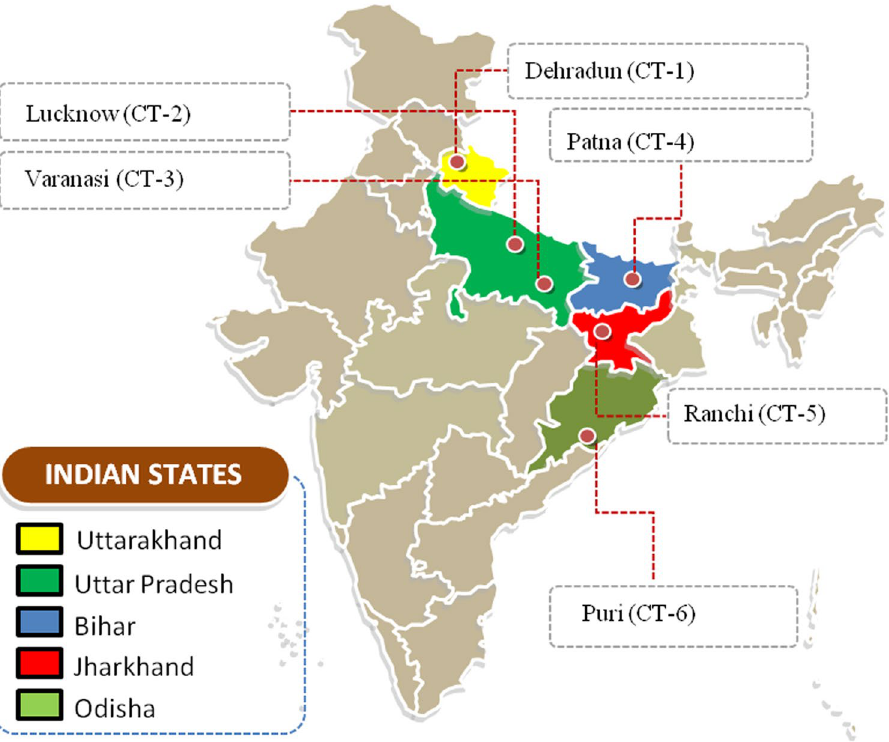
Figure 1. Collection sites of Cassia tora . This image is prepared with the help of an editable map of India (Source: